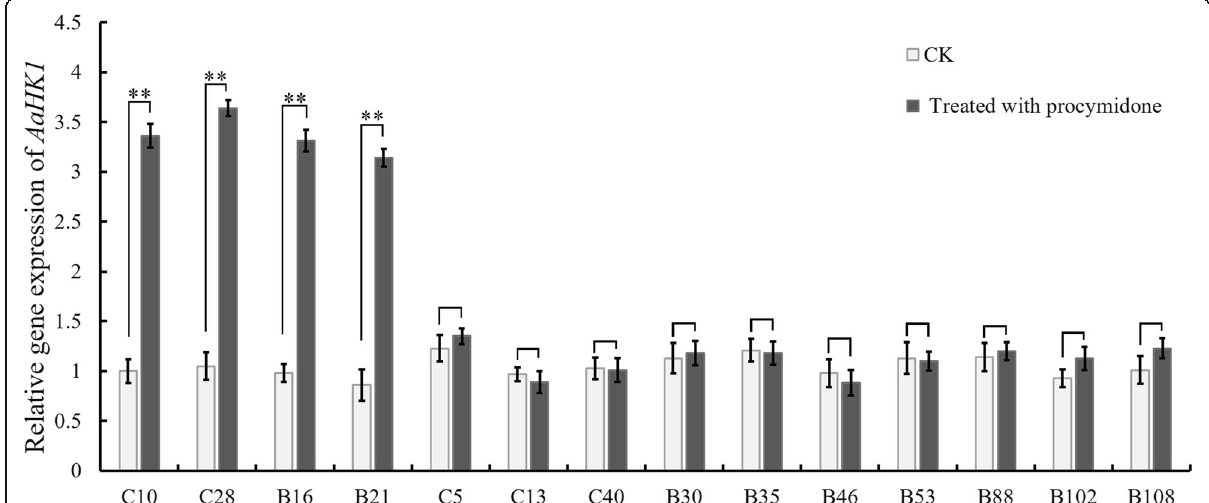
Fig. 6 The expression of AaHK1 gene in A. alternata Pro S and Pro HR isolates. The mycelia of each isolate were treated with procymidone at 0 or 10 μ g/mL after growth in PDB for 12 h. Bars denote the standard errors of three repeated experiments. The asterisk indicates significant difference between procymidone-treated sample and control. The Pro S isolates include C10, C28, B16 and B21. The Pro HR isolates include C5, C13, C40, B30, B35, B46, B53, B88, B102 and